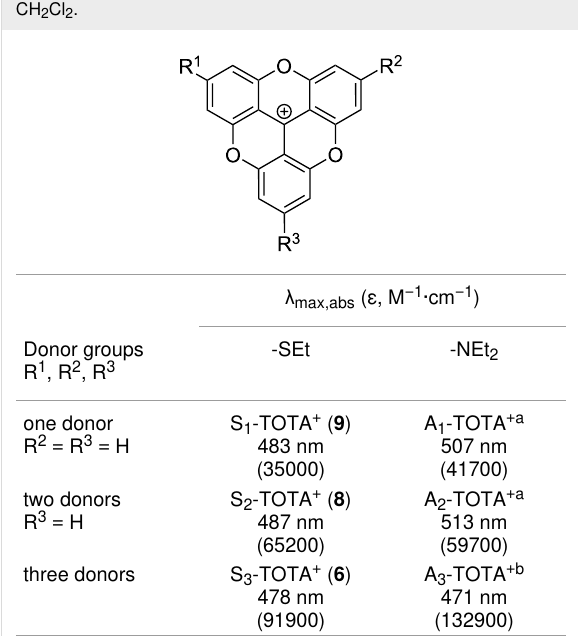
Table 2: Summary of absorption data of substituted TOTA dyes in CH 2 Cl 2